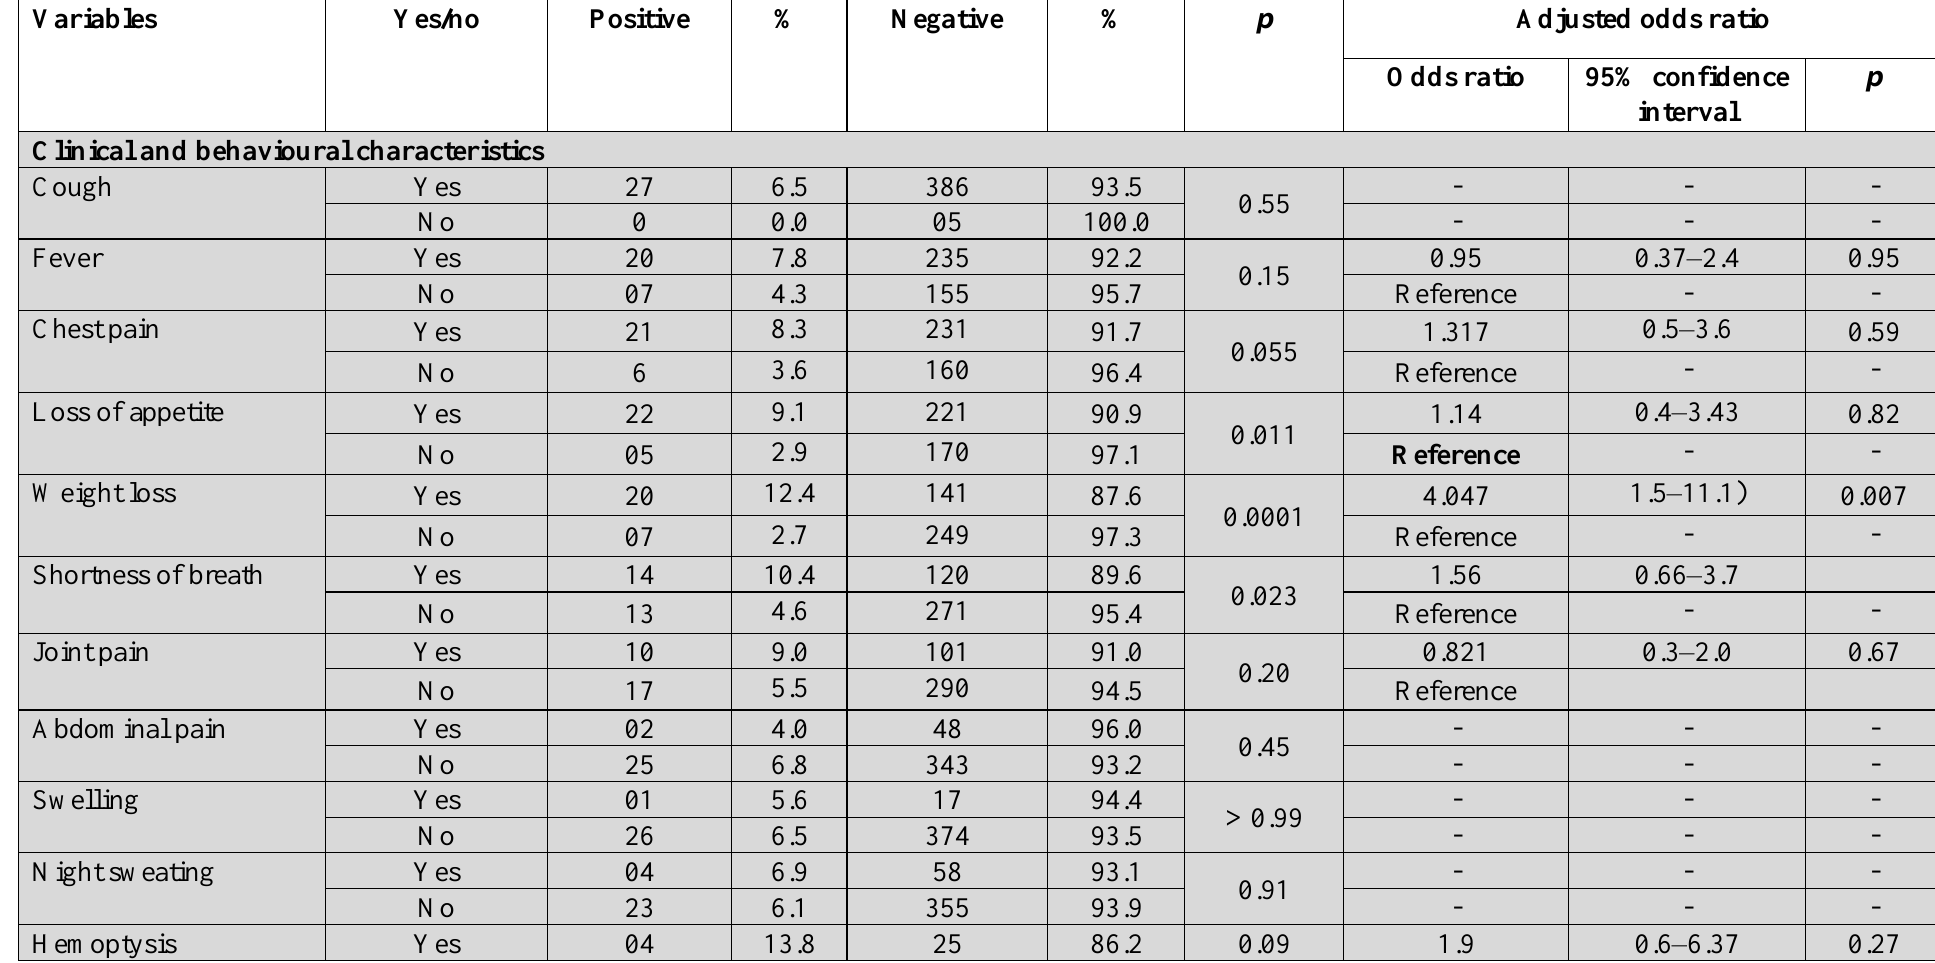
TABLE 1: Association of participant’s clinical presentation and behavioural characteristics with SNPT detection by the Xpert® MTB/RIF test in Addis Ababa, Ethiopia, from August 2017 to January 2018.